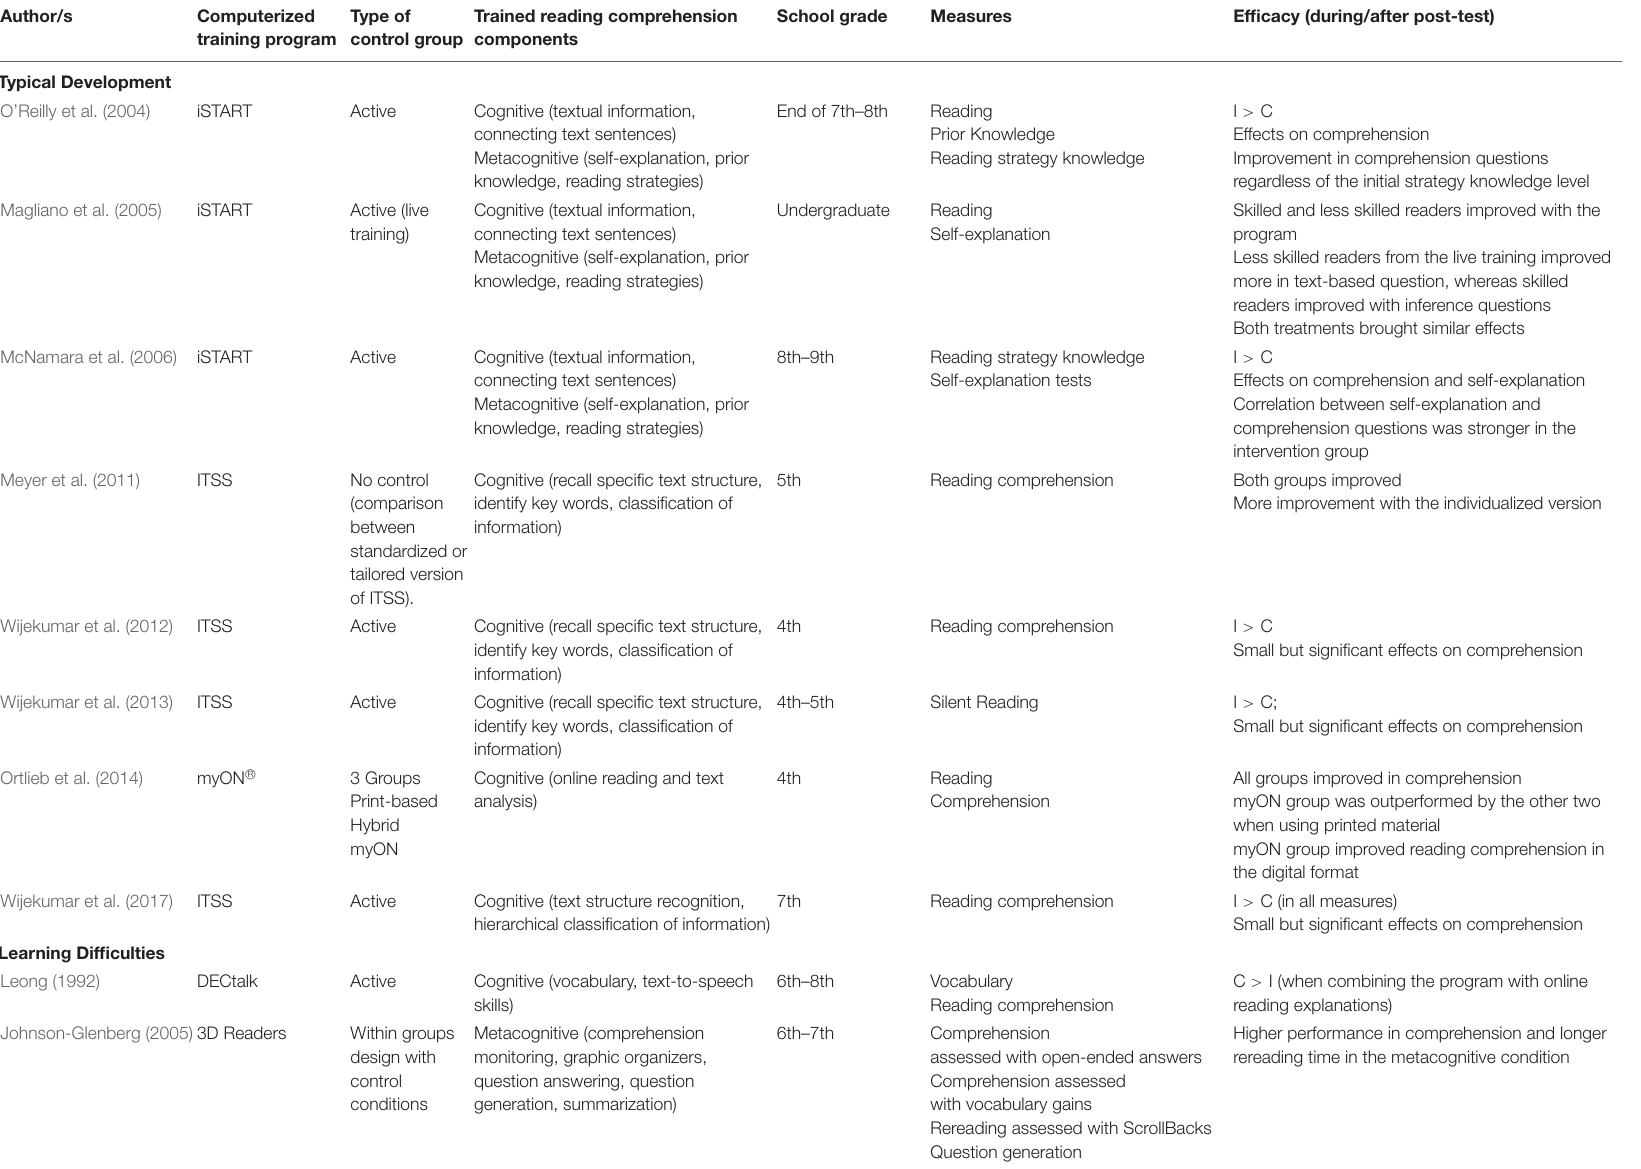
TABLE 1 | Synthesis of the main results of the computerized training programs on comprehension present in the literature.